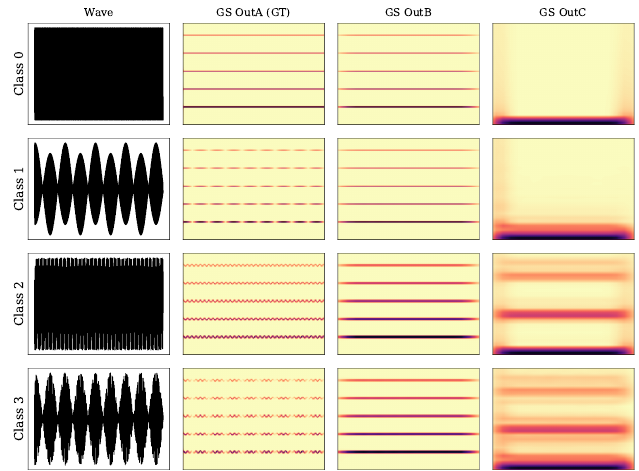
Figure 1. Wave Outputs A, i.e., GT; B; and C of Gabor scattering (GS) for all four classes of generated